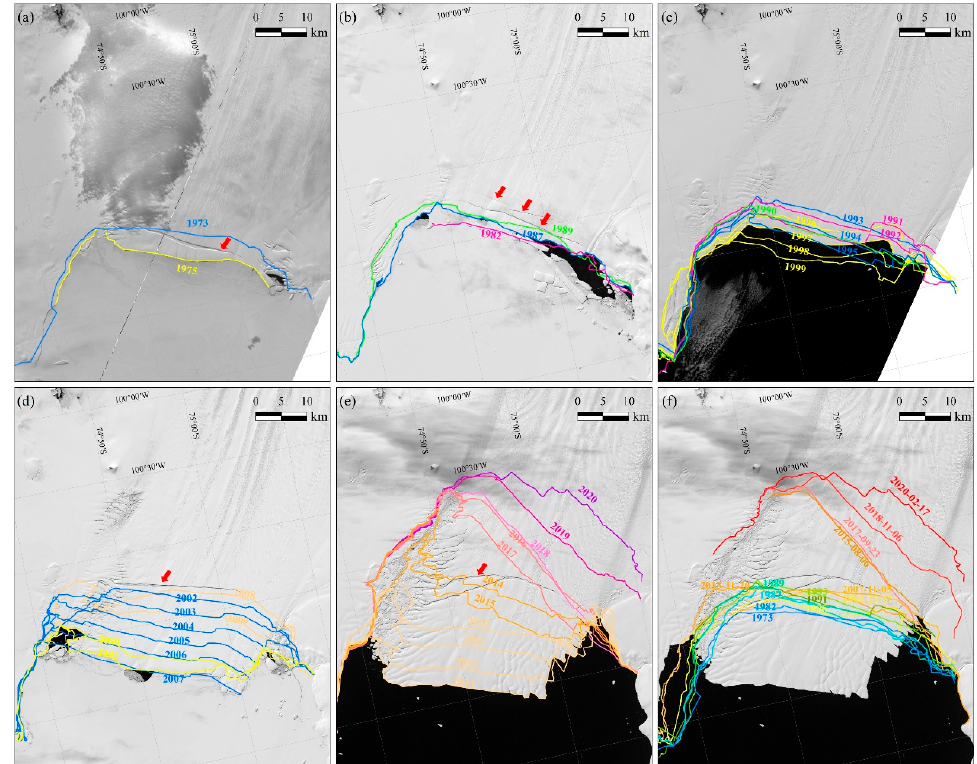
Figure 4. Time series of PIGIS fronts from 1973 to 2020. ( a ) 1970s, ( b ) 1980s, ( c ) 1990s, ( d ) 2000s, ( e ) 2010s, and 2020, ( f ) fronts in the most recent period after the ice shelf collapsed. Background images are: ( a ) Landsat-2 MSS, acquired on 13 February 1975, ( b ) Landsat-5 TM, acquired on 21 December 1986), ( c ) Landsat-5 TM, acquired on 04 February 1997, ( d ) Landsat-7 ETM+, acquired on 04